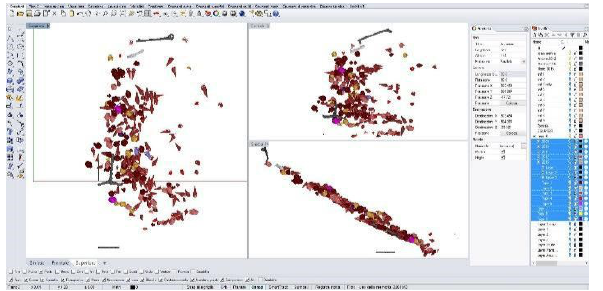
Figure 11. Virtual 3D database of the cargo.